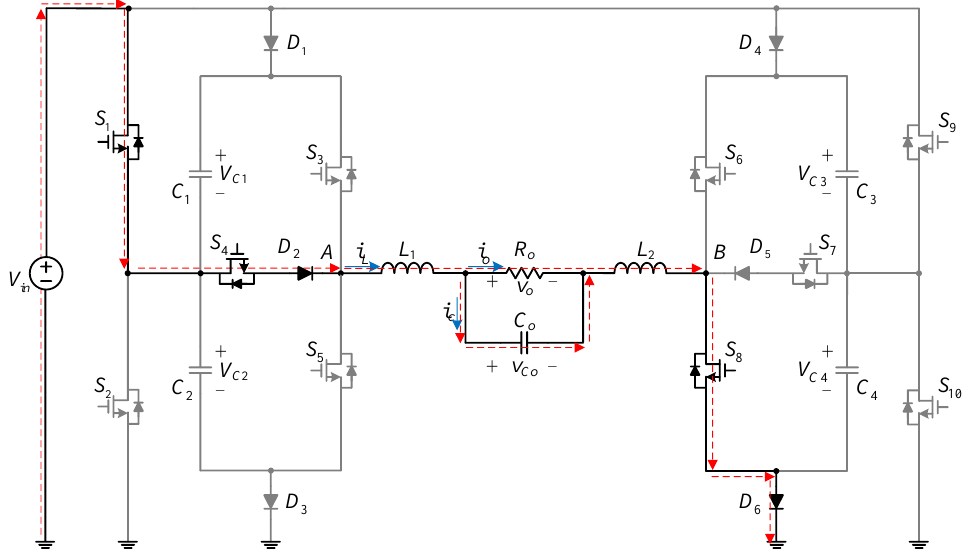
Figure 4. Power flow as S 4 is conducted.